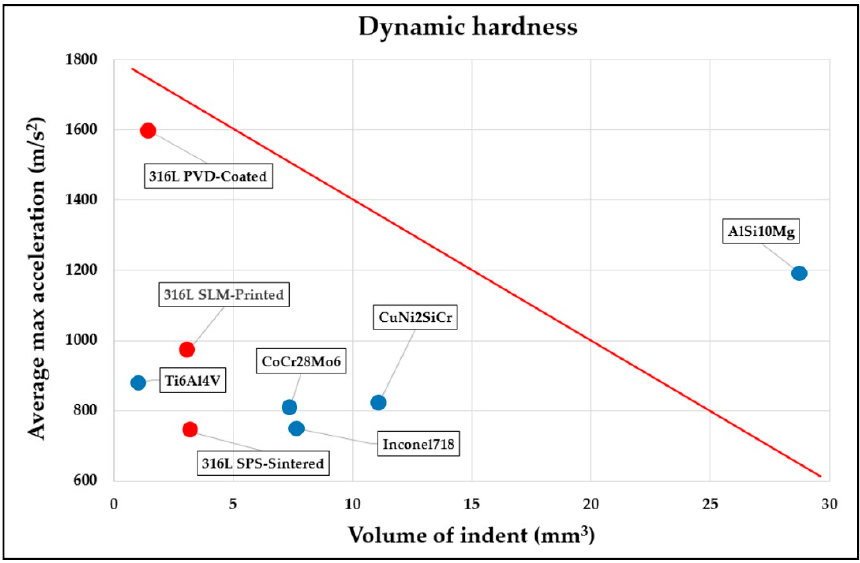
Figure 9. Dynamic hardness graph for SPS-sintered, 316L SLM-printed, and 316L PVD-coated metallic alloys. Proximity to the red line indicates the material that spent most of the energy on plastic deformation.